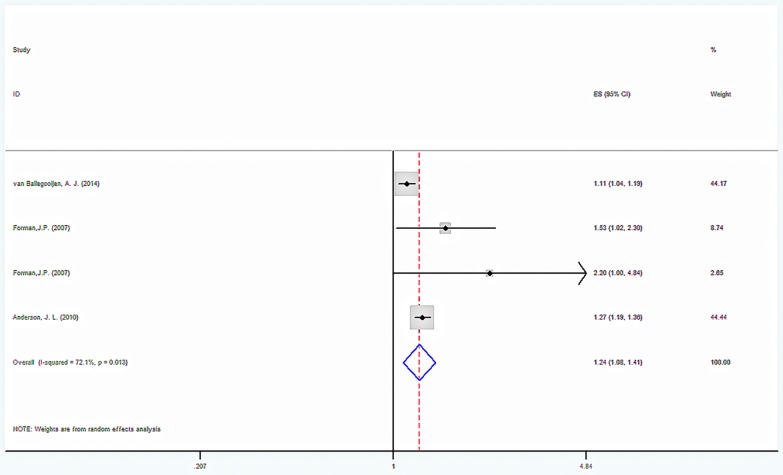
Forest plot for vitamin D sufficient VS deficient.Hazard ratios of hypertension of the deficient versus sufficient category of blood 25(OH)D concentration. CI indicates confidence interval. The size of each square is proportional to the study’s weight.